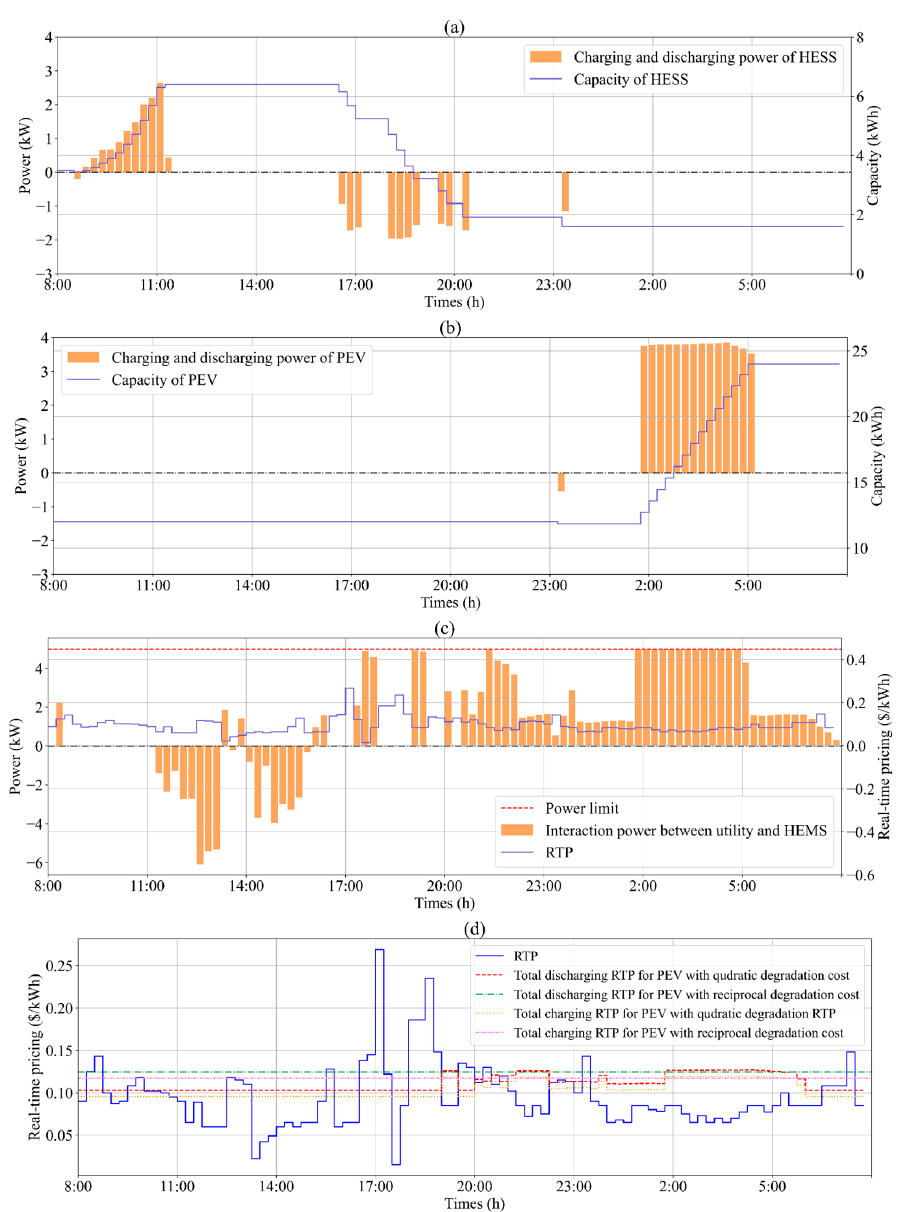
Figure 16. Load profiles for ( a ) HESS in HESS2H mode, ( b ) PEV in V2H mode, ( c ) H ‐ MG combined mode segmentation strategy, and ( d ) RTP comparison of PEV considering degradation cost.